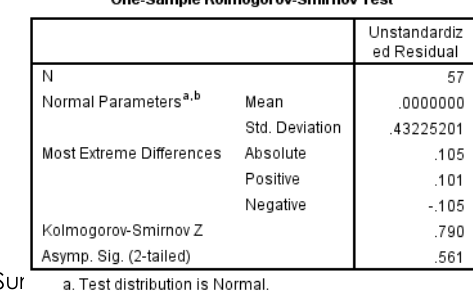
Tabel 11 Hasil Uji One- Sample Kolmogorov- Smirnov Test